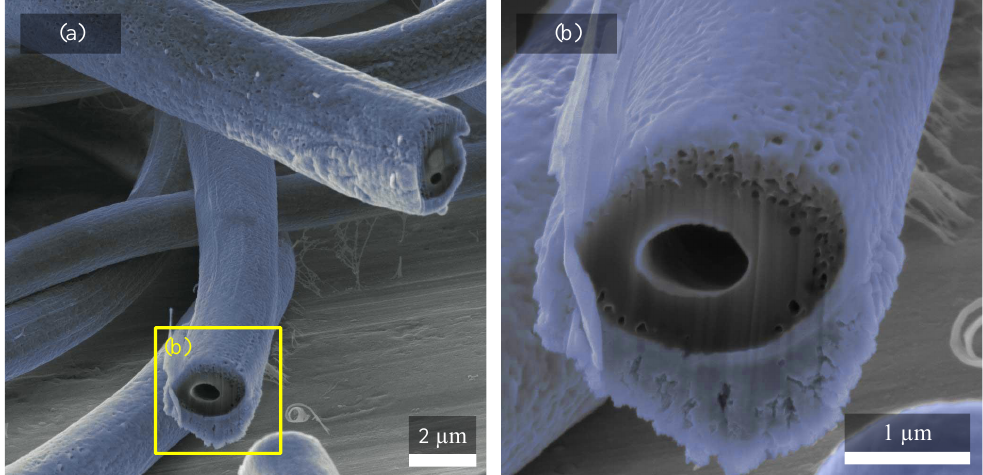
Figure 5. Example of PVDF nanofibers that have been cut using FIB. Several interesting aspects can be seen in ( a ). In the fiber cut at the upper part, it can be seen that its structure is not perfectly oval. Both cut fibers appear hollow in some parts, or it may also be an air bubble. On closer examination in ( b ), it can be seen that particularly in the surface region, the fibers are quite porous. Since PVDF is the polymer, it has been coated to prevent charging of fibers, as indicated by the color highlighting